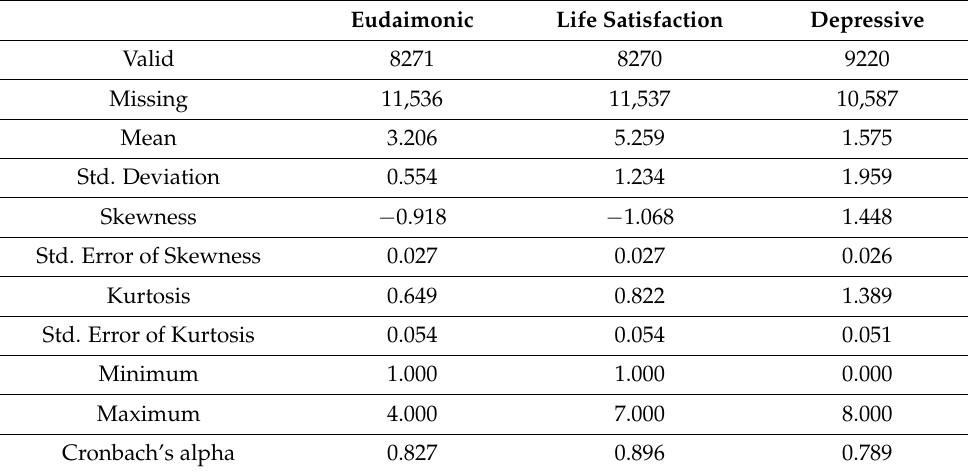
Table 1. Descriptive Statistics and Internal Reliabilities (Time Point